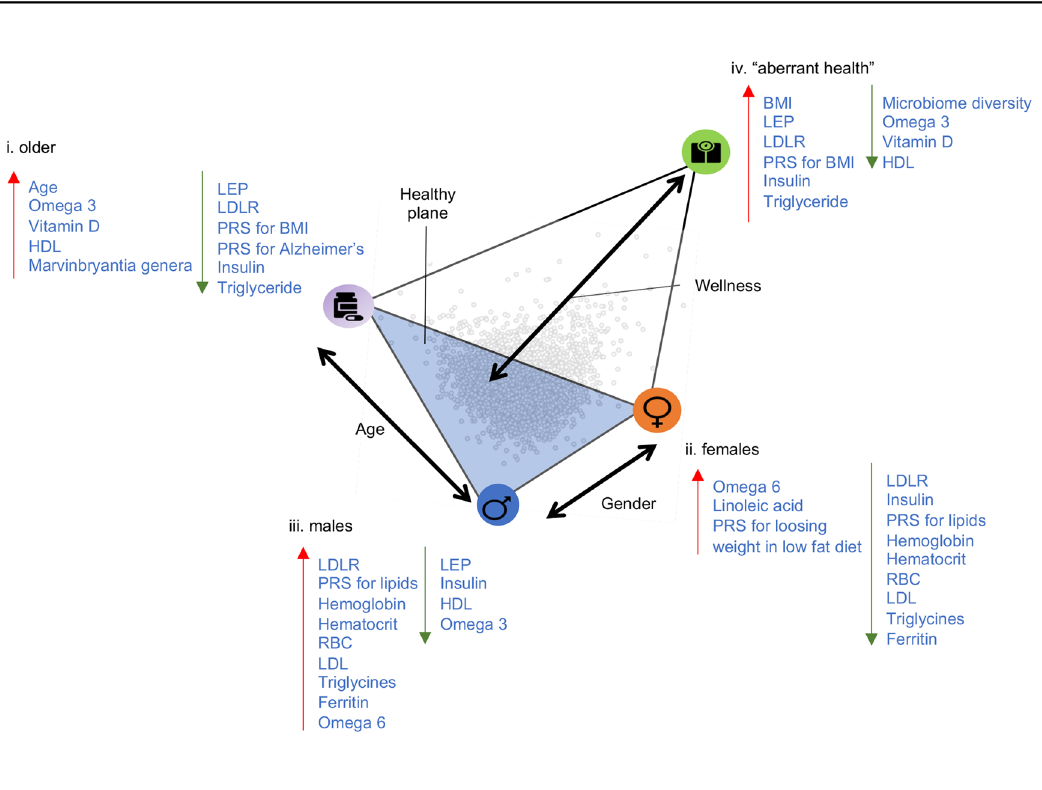
Fig. 3 The enrichment analysis revealed one aberrant health state, and three wellness states: (1) the older-archetype (2) the female-archetype (3) the male-archetype. Written in blue are the traits that are found to be enriched close to every archetype at high (left) or low (right) levels. Also shown are the major axes of the data variation (also shown and described in Fig. 4, n =